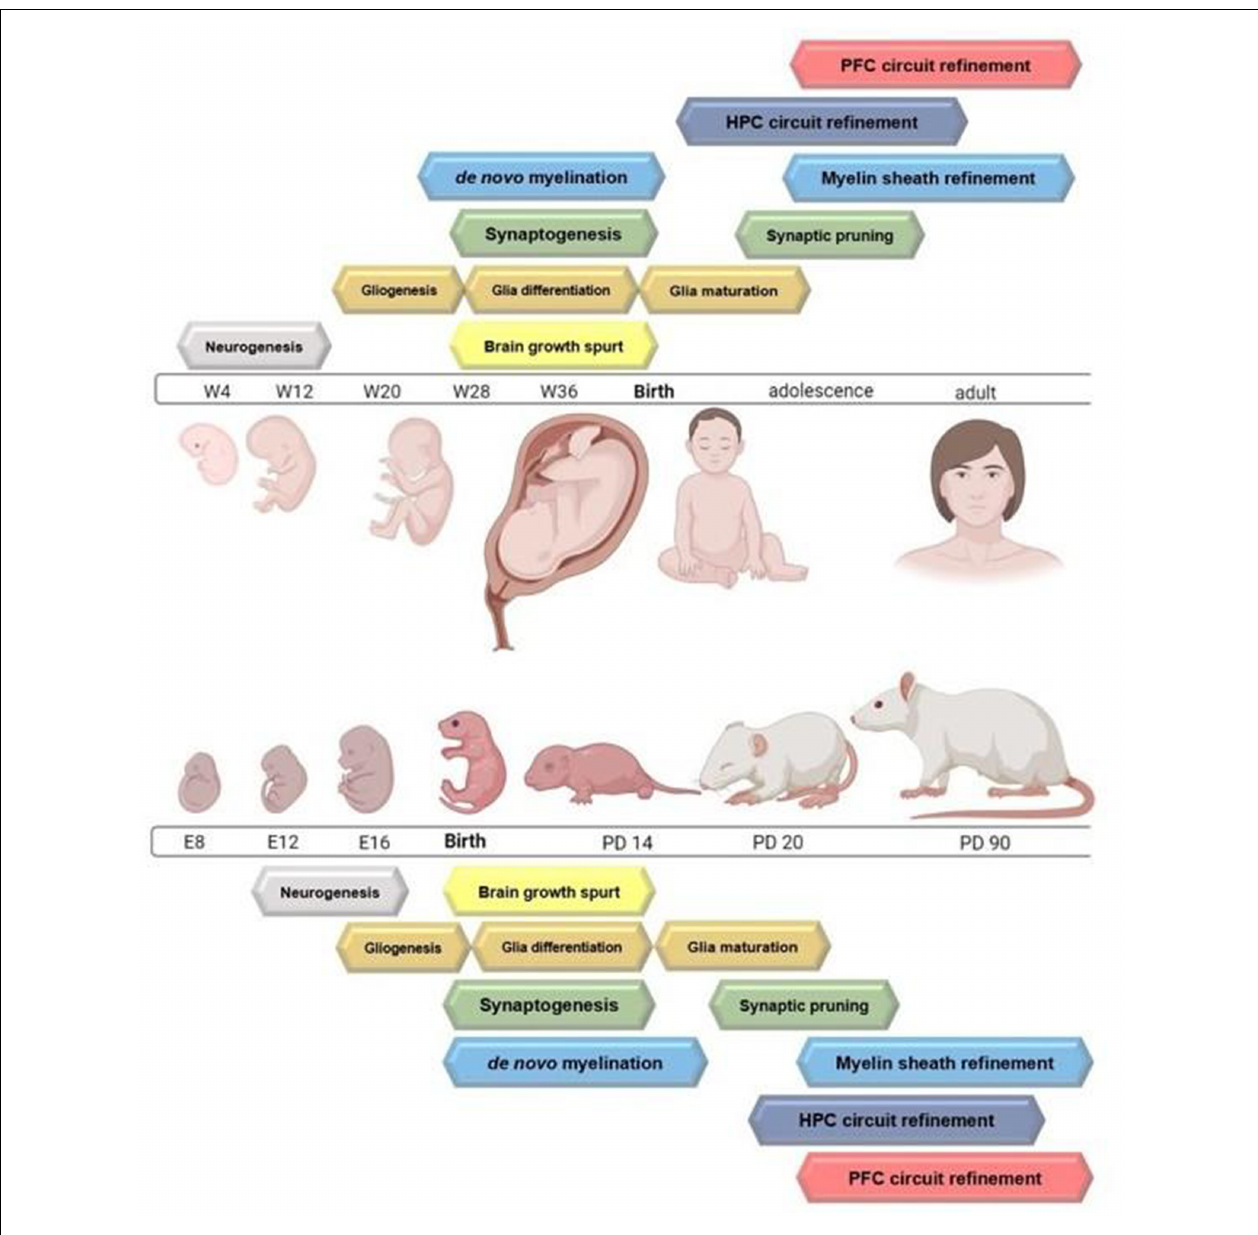
FIGURE 1 | Timelines highlighting the peak of major neurodevelopmental processes occurring from gestation through adulthood in the rodent and humans. Circuit refinement of the hippocampus compared to the prefrontal cortex is also depicted. Figure created with BioRender.com.